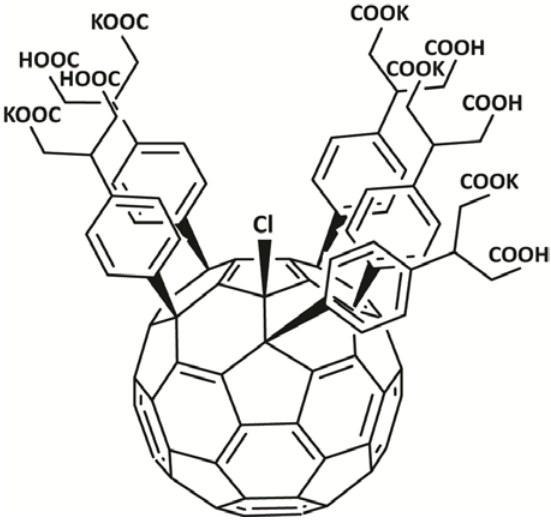
Figure 1. The molecular formula of F1 .